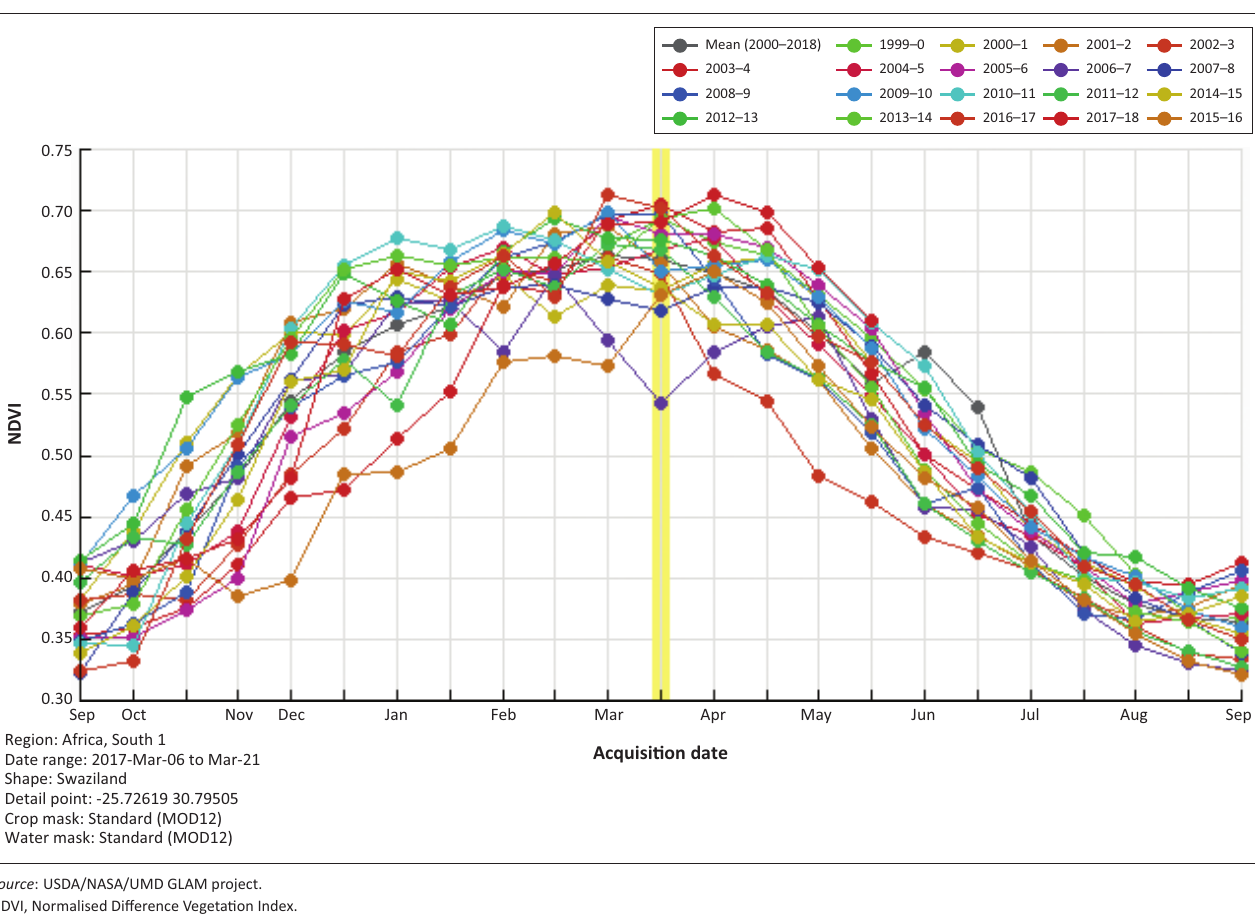
FIGURE 3: MODIS NDVI (Terra) (MOD44 16 days) graph for